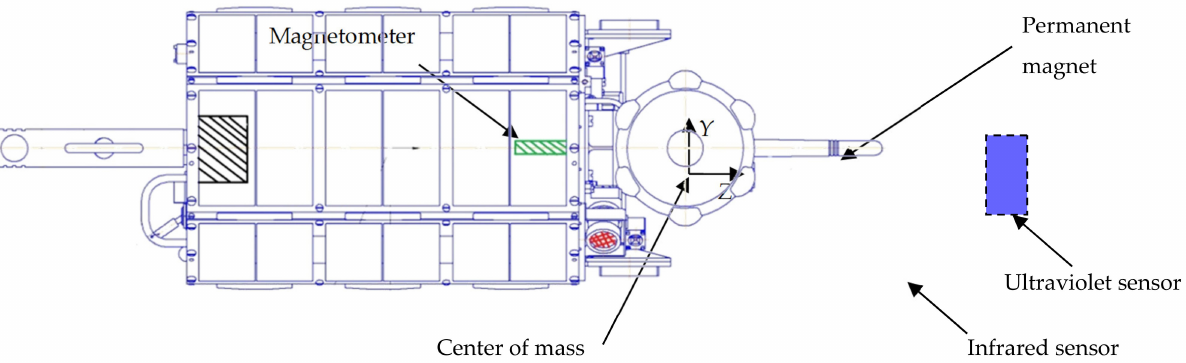
Figure 2. Center of mass location, permanent magnet, magnetometer and Sun sensors positions in the satellite